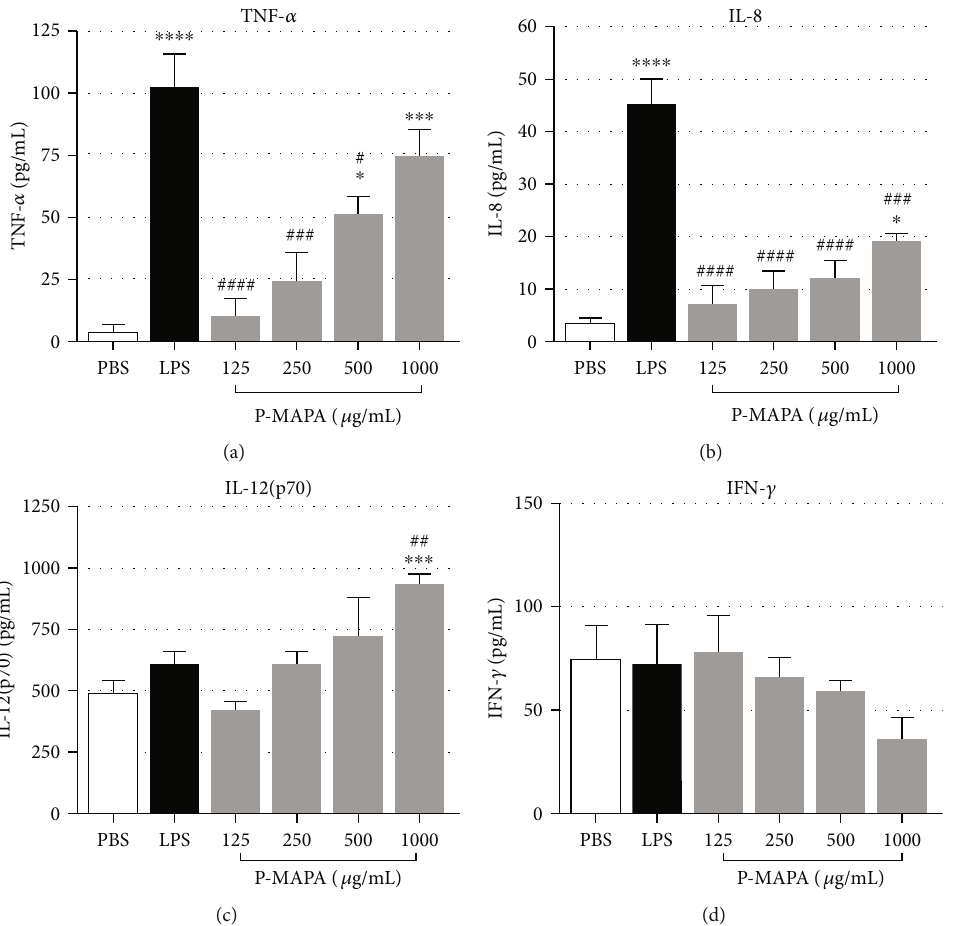
Figure 4: Cytokine production poststimulation of human whole blood with P-MAPA. Cytokines were measured in plasma collected from blood stimulated with PBS, LPS (100 μ g/mL), or P-MAPA for 30 minutes at 37 ° C. (a) TNF- α (assay detection limit 7.8pg/mL), (b) IL-8 (assay detection limit: 3.1pg/mL), (c) IL-12(p70) (assay detection limit: 7.8pg/mL), and (d) IFN- γ (assay detection limit: 4.7pg/mL) productions are expressed as the mean ± SEM . Data are the mean of three separate experiments, from three di ff erent donors, performed in duplicate, and the results are expressed as concentration of each cytokine per mL of human plasma (pg/mL). Statistical analysis was performed by one-way ANOVA, complemented with the Tukey test. ∗ p < 0 : 05 , ∗∗ p < 0 : 01 , ∗∗∗ p < 0 : 001 , and ∗∗∗∗ p < 0 : 0001 : signi fi cant di ff erences between the mean values with PBS control. # p < 0 : 05 , ## p < 0 : 01 , ### p < 0 : 001 , and #### p < 0 : 0001 : signi fi cant di ff erences between the mean values with